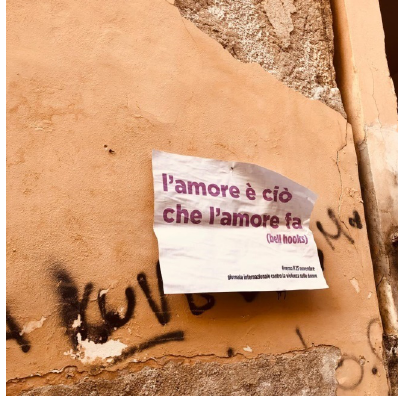
Figg. 3, 4 : Palermo, ZEN 2, 25 November